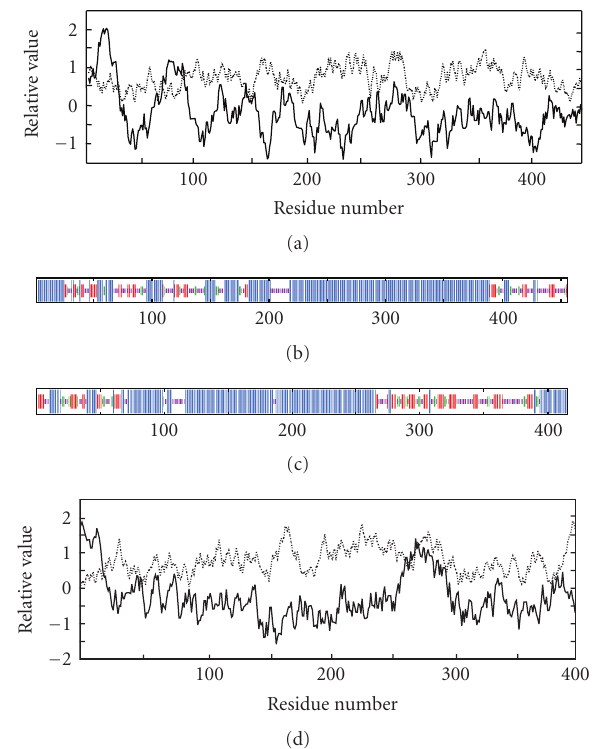
Figure 3: Comparison of the predicted properties of the OMA of S. meliloti ((a) and (b)) with the MFP of N. mobilis ((c) and (d)) (see Figure 1). (a) Average hydropathy (solid line) and amphipathicity (dotted line) plots for the OMA (WHAT program; [23]). (b) Secondary structure predictions for the same OMA (SOPMA program, [24]). (c) Secondary structure predictions for the MFP of N. mobilis . (d) Average hydropathy and amphipathicity plots for the same MFP. The two sequences were aligned using the GAP program ([21]; Figure 1) which was used to prove homology. The single peaks of hydrophobicity correspond to the N-terminal transmembrane signal helices present in both proteins. In (b) and (c), long vertical lines indicate regions of predicted α -helix, intermediate length vertical lines indicate regions of β -sheet, and shorter vertical lines indicate regions of random coil or β